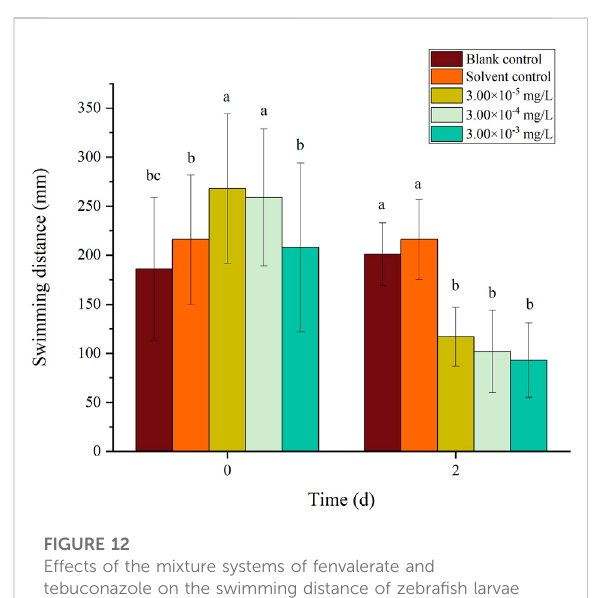
FIGURE 12 Effects of the mixture systems of fenvalerate and tebuconazole on the swimming distance of zebra fi sh larvae